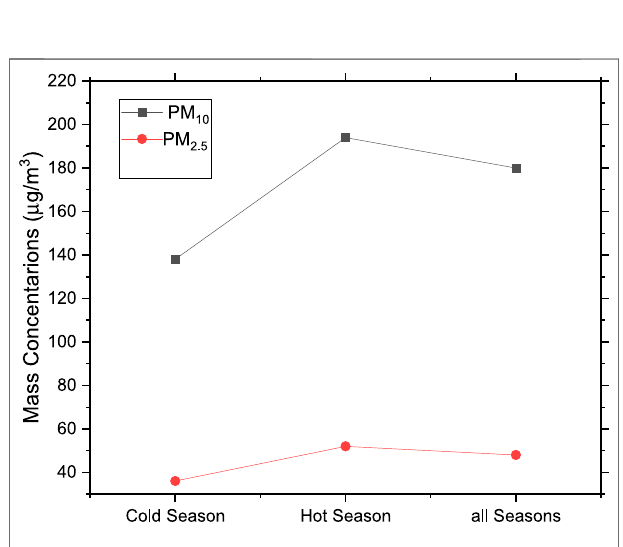
FIGURE 2 | Seasonal average mass concentrations of PM 10 and PM 2.5